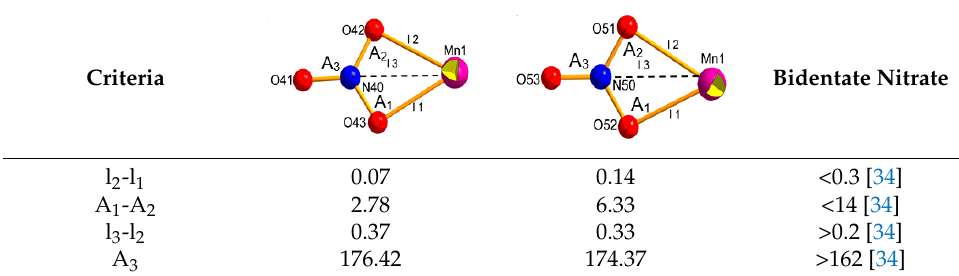
Table 2. Structural criteria used for assigning nitrate modes for the Mn-dipyCO-NO 3 complex [Å, °].